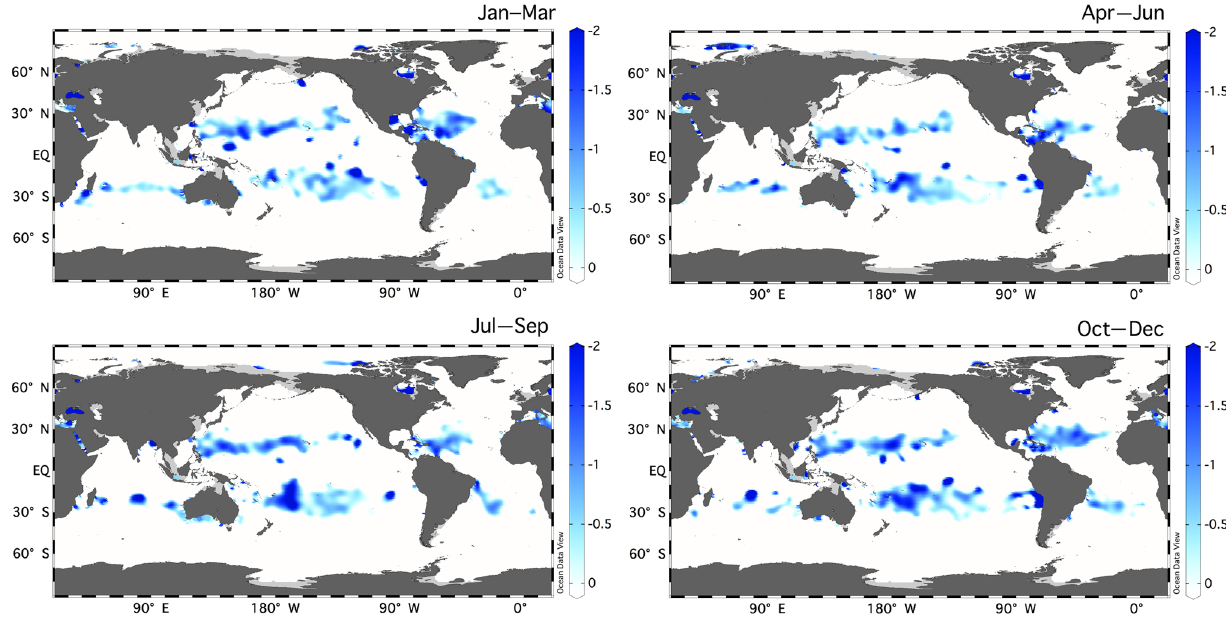
Figure 5. Seasonal climatology of the residual preNO 3 tracer [µM] at 150m depth from the World Ocean Atlas (2013) 1 ◦ climatologies of O 2 anomaly and nitrate. Residual preNO 3 is calculated using values of f DOM = 0 . 5, r DOM = 20 . 0, and r POM = 8 .